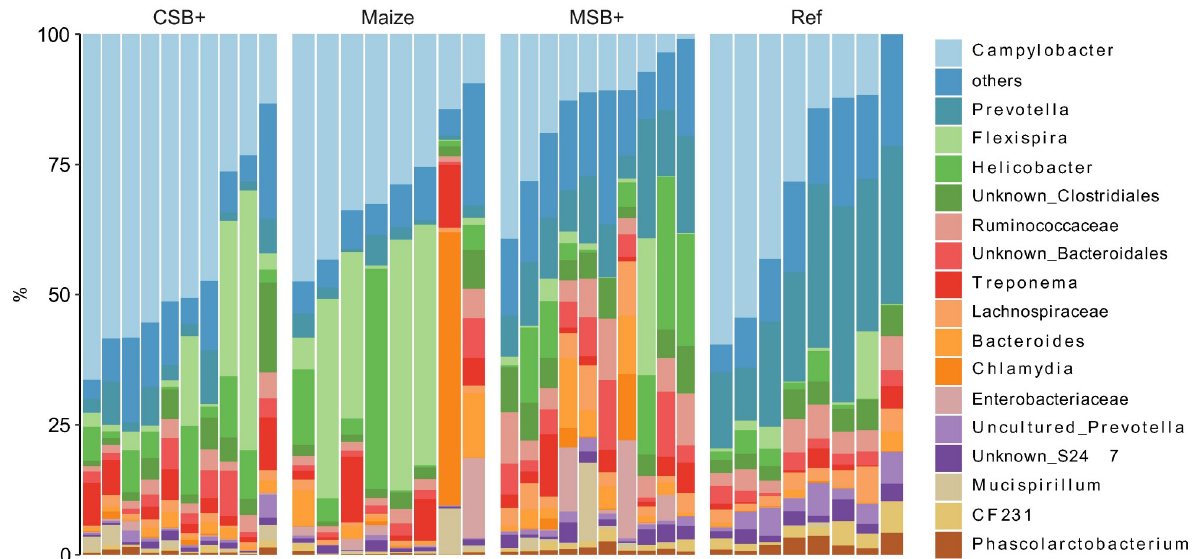
Fig 4. Relative abundance of colon mucosal microbiome members summarized at genus level. For CSB+ and MSB+, n = 10; For Maize and Ref, n =